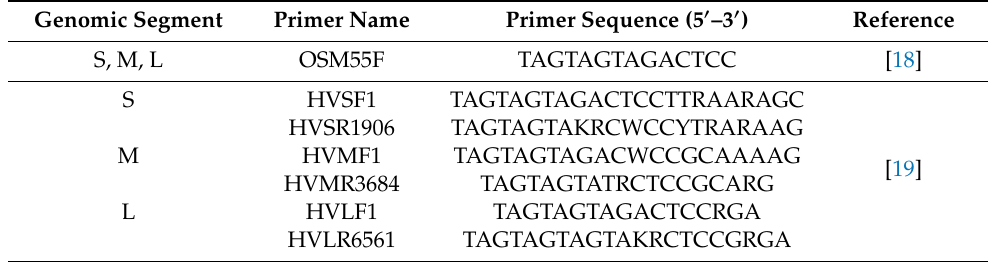
Figure 1. The distribution area of Bronze Tube-nosed Bat ( Murina aenea ) according to the IUCN (International Union for Conservation of Nature) Red List database is marked with red colour. Collection sites for the study are marked with blue dots. Table 1. Oligonucleotide primers used to amplify the complete S, M, and L segments of Sarawak mobatvirus.